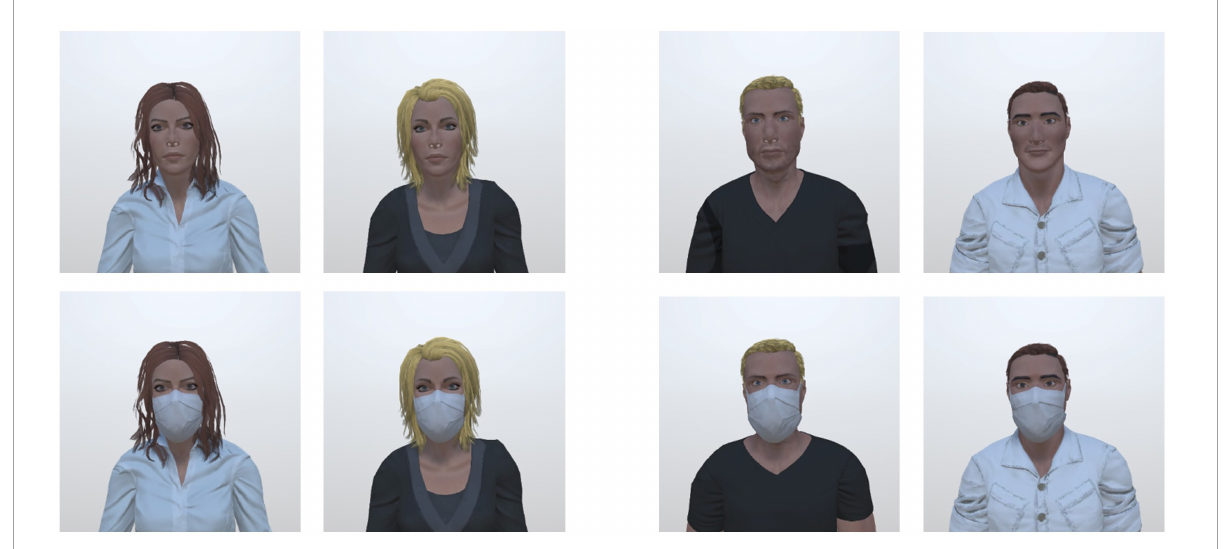
FIGURE1 Virtual characters used in the three experimental tasks (male and female characters with a neutral facial expression wearing a face mask or not from the ATHOS database; Cartaud and Coello,